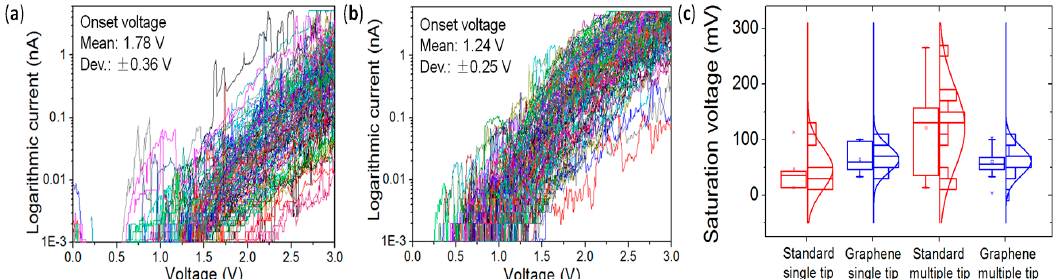
Figure 13. 100 backward I–V curves collected with both standard ( a ) and graphene coated nanoprobes; ( b ) the onset voltage and the deviation of the graphene nanoprobes is much smaller. Reproduced with permission from [28], copyright The Royal Society of Chemistry (2016); ( c ) Variance statistics analysis for single and multiple tip measurements at the saturation voltage (I = − 5 nA) for fresh probes (in red) or graphene coated (in blue). Reproduced with permission from [52], copyright Elsevier (2016).